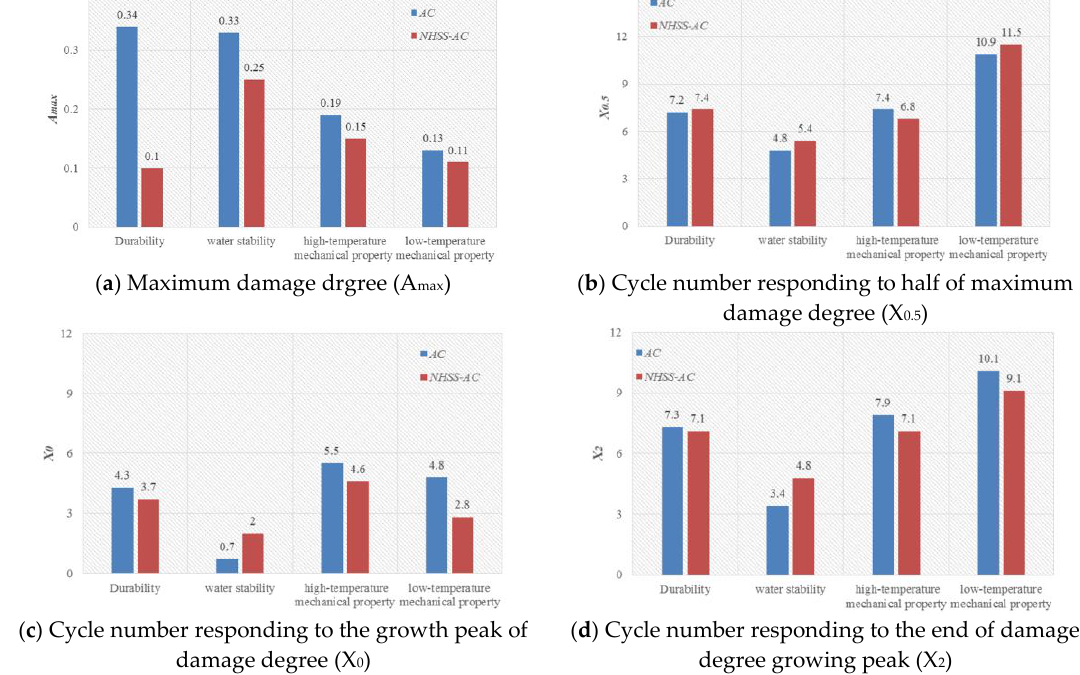
Figure 11. Parameters of the Logistic damage model.